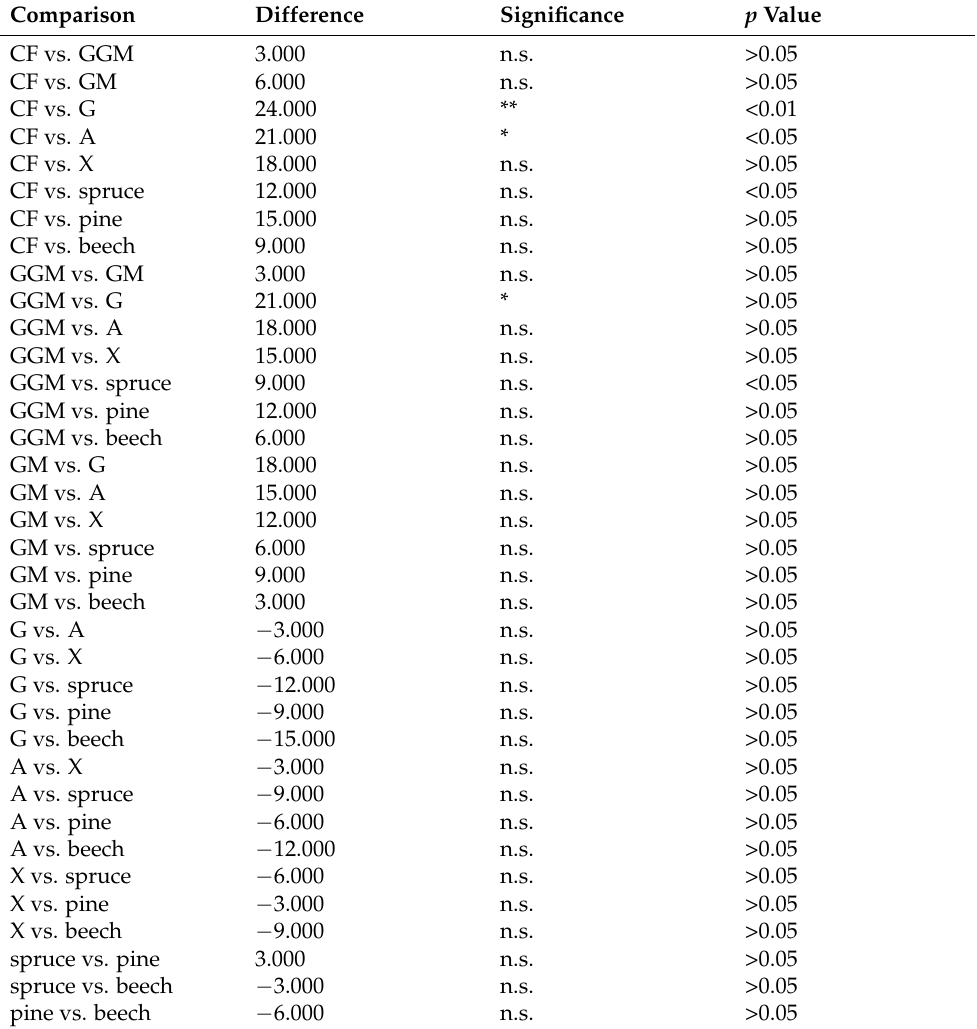
Table 2. The comparison of absorbance values for all three replicates of “caffeine + the individual sugar(s)” minus “the same sugar(s)” were compared using multivariate nonparametric ANOVA, Kruskal-Wallis Test (significance: n.s. = not significant; * = low significance corresponding to difference 21.000; **= higher significance corresponding to difference